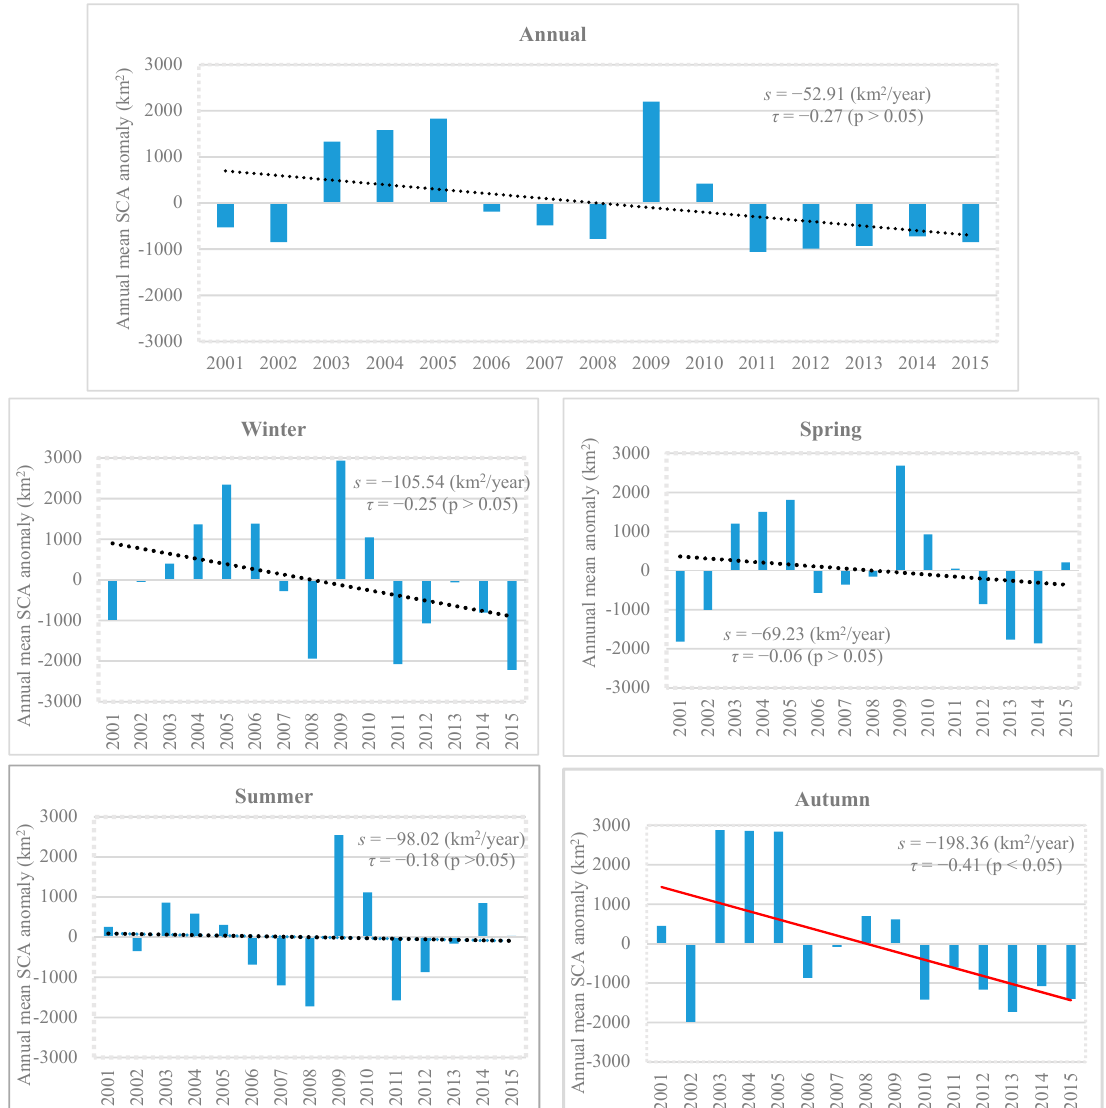
Figure 7. Annual and seasonal mean SCA anomalies for the period 2001–2015. Mann Kendall’s trend test “ τ ” and Sens’s slope estimator “ s